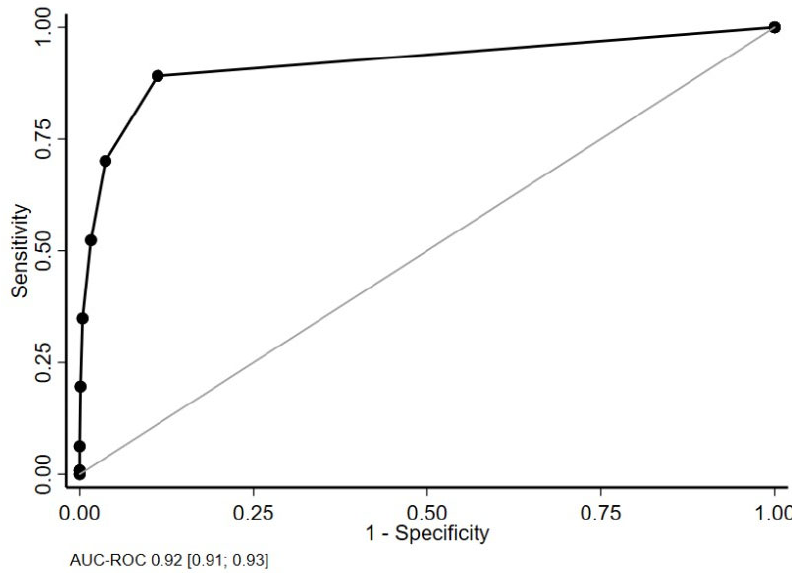
Figure 4. Receiver operating characteristic curve for the national data.